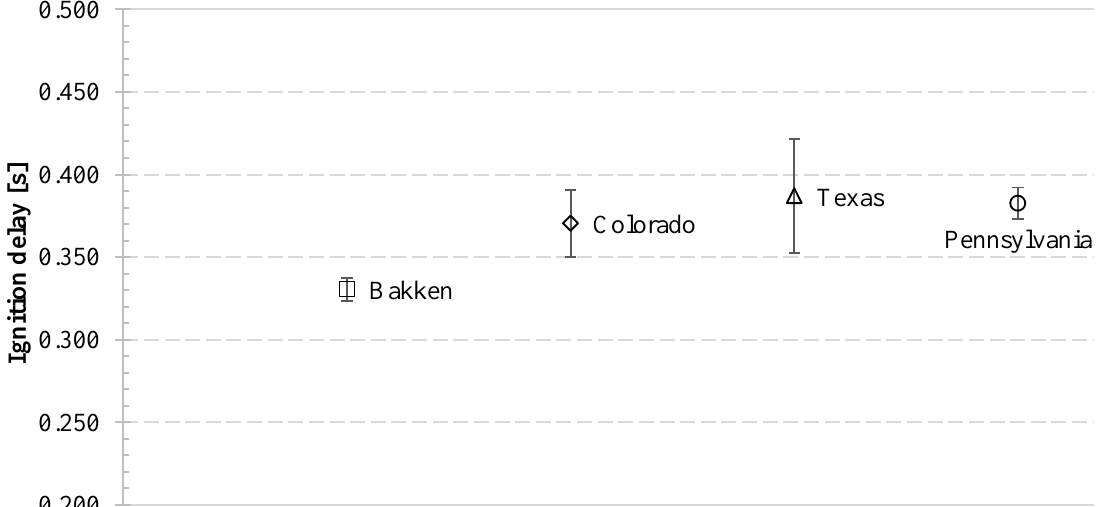
Figure 12. Average ignition delay for di ff erent crude